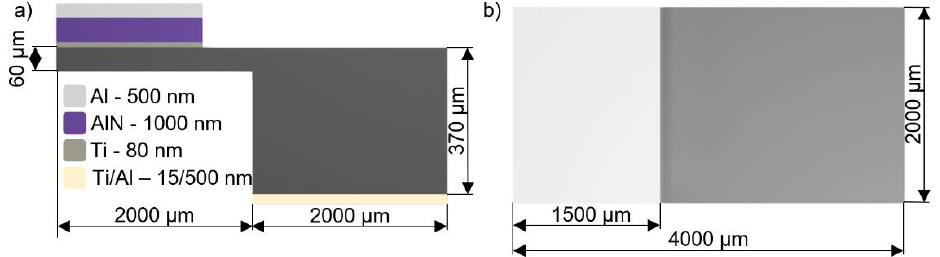
Figure 1. Layer composition and their dimensions of piezoelectric energy harvesters (PEH) (not to scale): ( a ) side view; ( b ) top view.